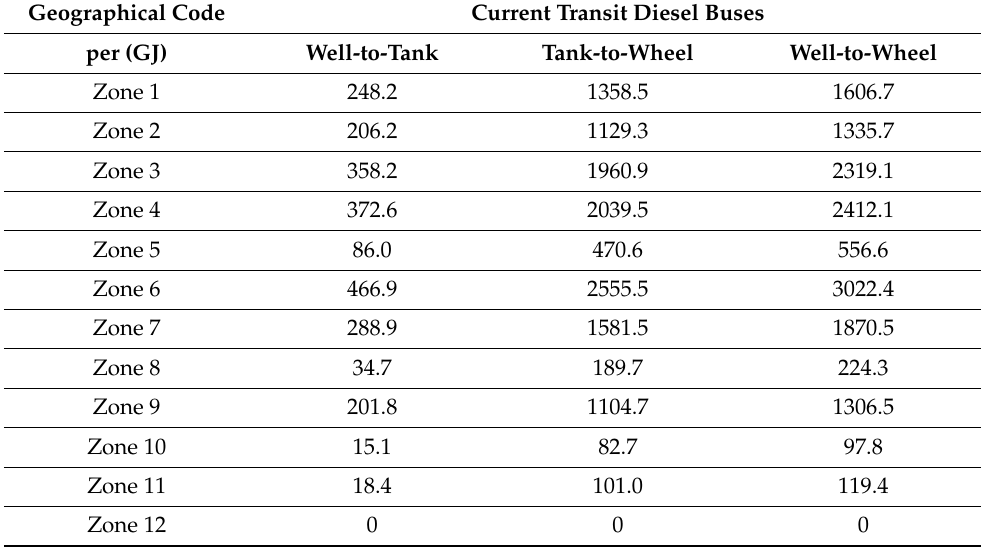
Table A3. Daily Energy Consumption from Public Buses by